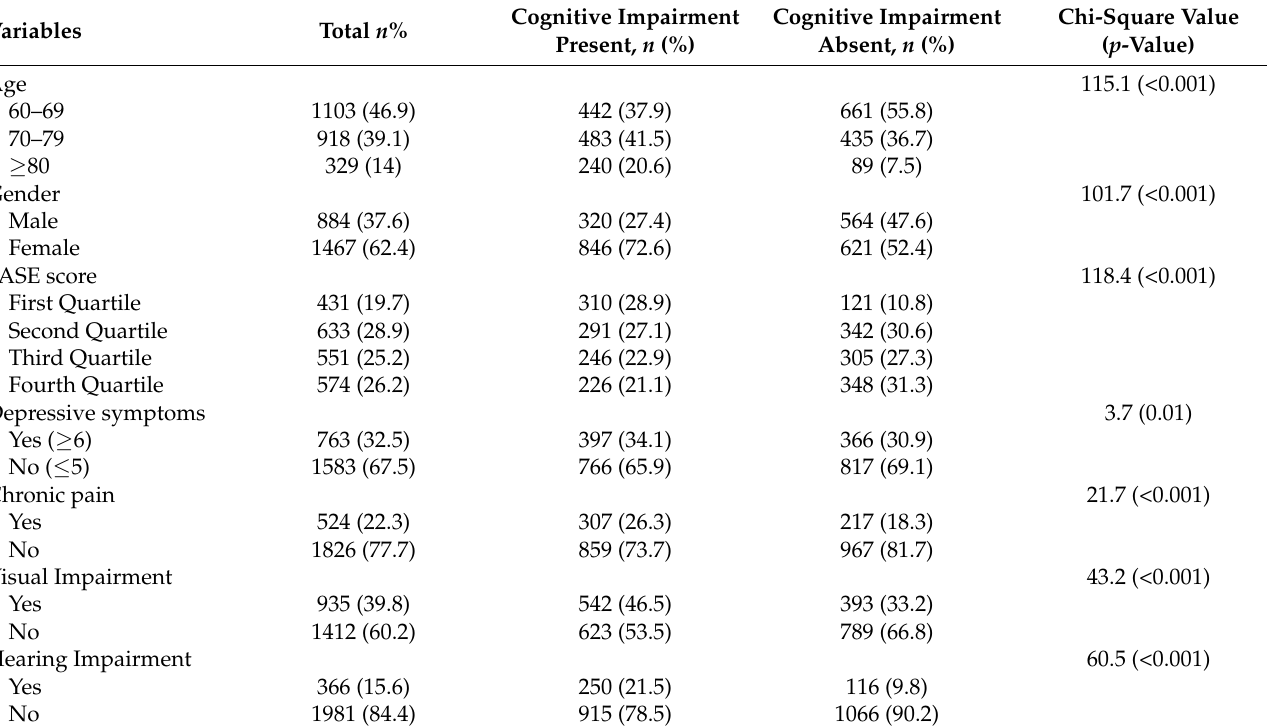
Table 1. Baseline sociodemographic details of the study